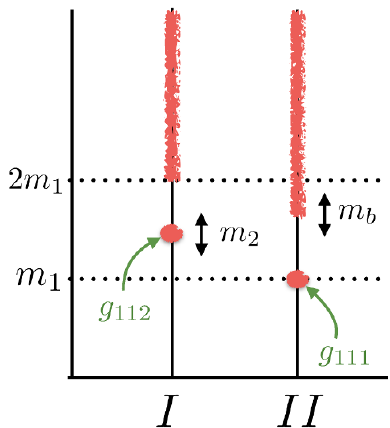
Figure 4 . In scenario I we vary m 2 and (cid:12)nd an upper bound on g 112 . In scenario II we vary m b and (cid:12)nd an upper bound on g 111 . In both scenarios the mass of the scattered particle is m 1 . but in AdS it is described instead by the CT four-point function